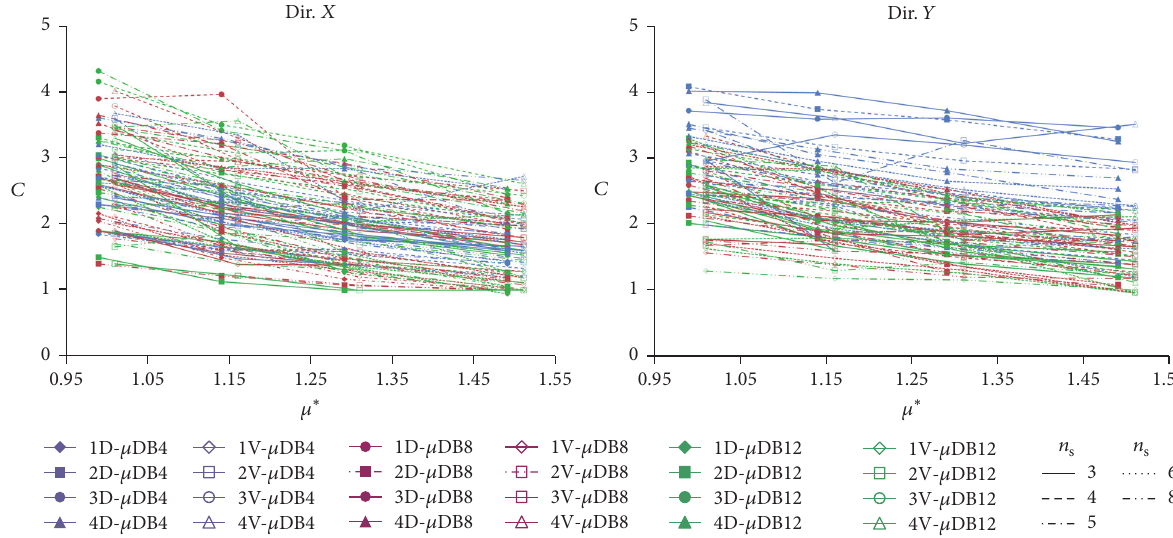
Figure 12: Correlation between 𝐶 and the ductility demand on the bracing 𝜇 DB , the number of storeys 𝑛 s , the ratio between periods 𝑇 B ∗ /𝑇 ∗ , and the ratio between resistances 𝐹 DB /𝐹 y ∗ . Dir. X Dir. Y